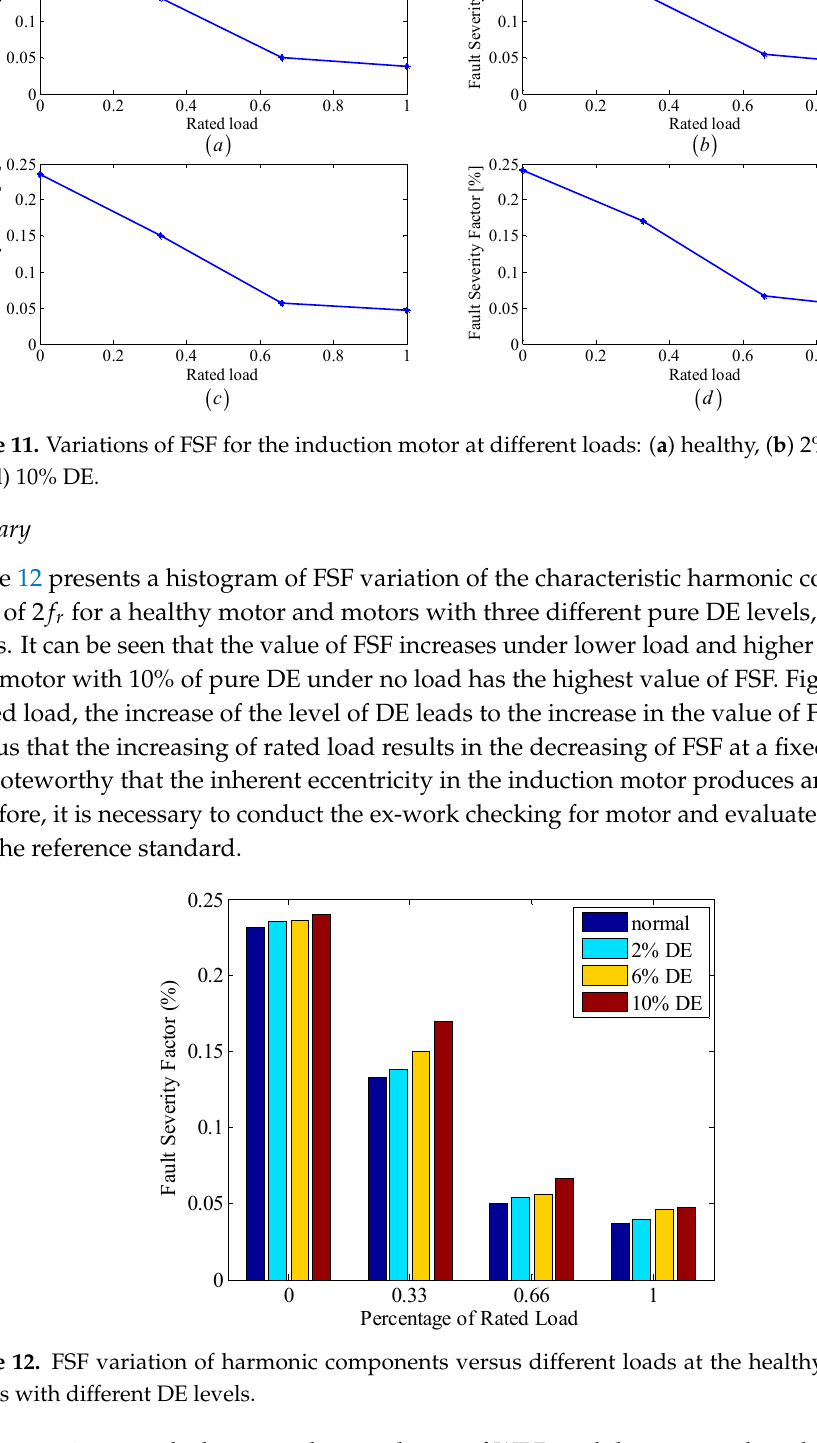
f for the healthy and faulty motors from no load r